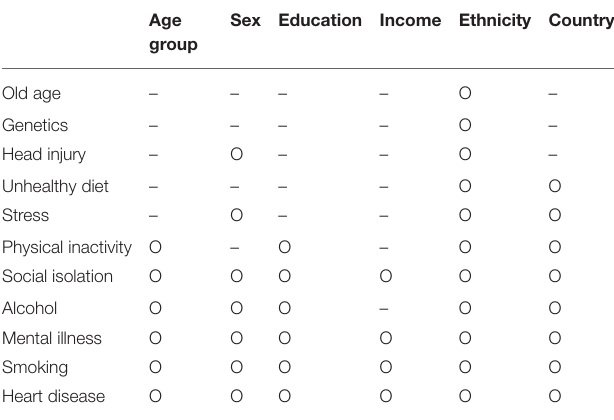
TABLE 3 | Scoring distribution relationships with demographic variables using Kruskal-Wallis omnibus